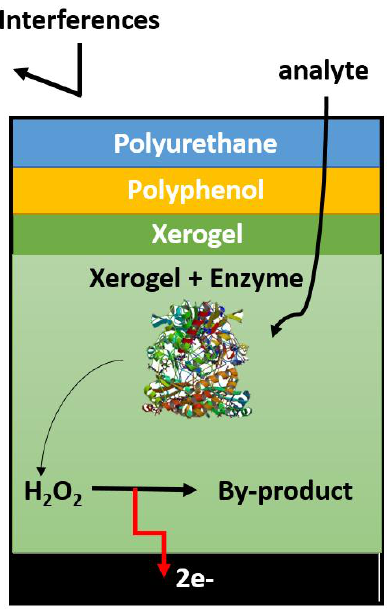
Figure 8. Schematic diagram of a xerogel-based, first-generation amperometric glucose biosensor featuring an enzyme doped and diffusion-limiting xerogel layers and capped with semipermeable electropolymerized polyphenol and polyurethane outer membranes.